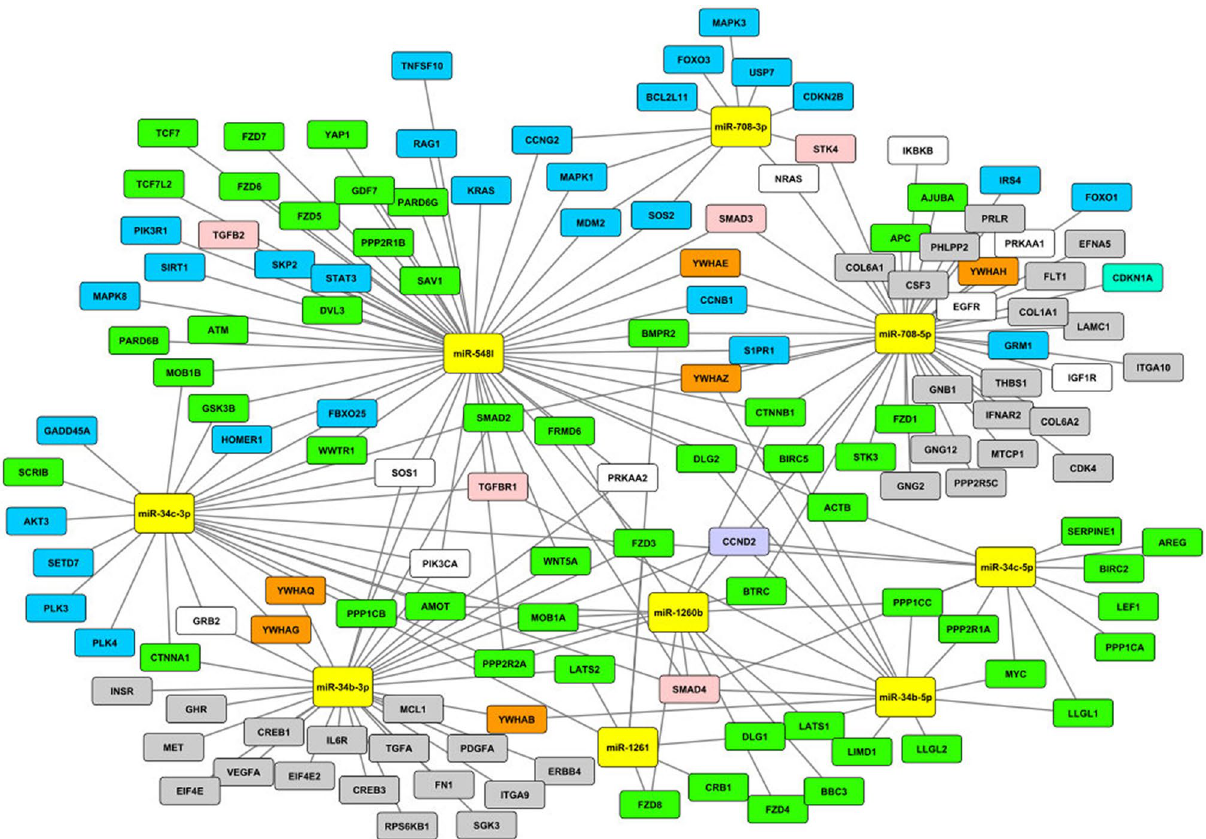
Figure 3. miRNA regulation of genes involved in Hippo, Foxo and PI3K-Akt pathway. The yellow box nodes represent miRNAs; green nodes describe genes located in the Hippo pathway; blue nodes describe genes located in the Foxo pathway; grey nodes describe genes located in the PI3K-Akt pathway; pink nodes describe genes located in both the Hippo and Foxo pathways; orange nodes describe genes located in both the Hippo and PI3K-Akt pathways; purple node describes gene located in the Hippo, PI3K-Akt and Foxo pathways; white nodes describe genes located in both the PI3K-Akt and Foxo